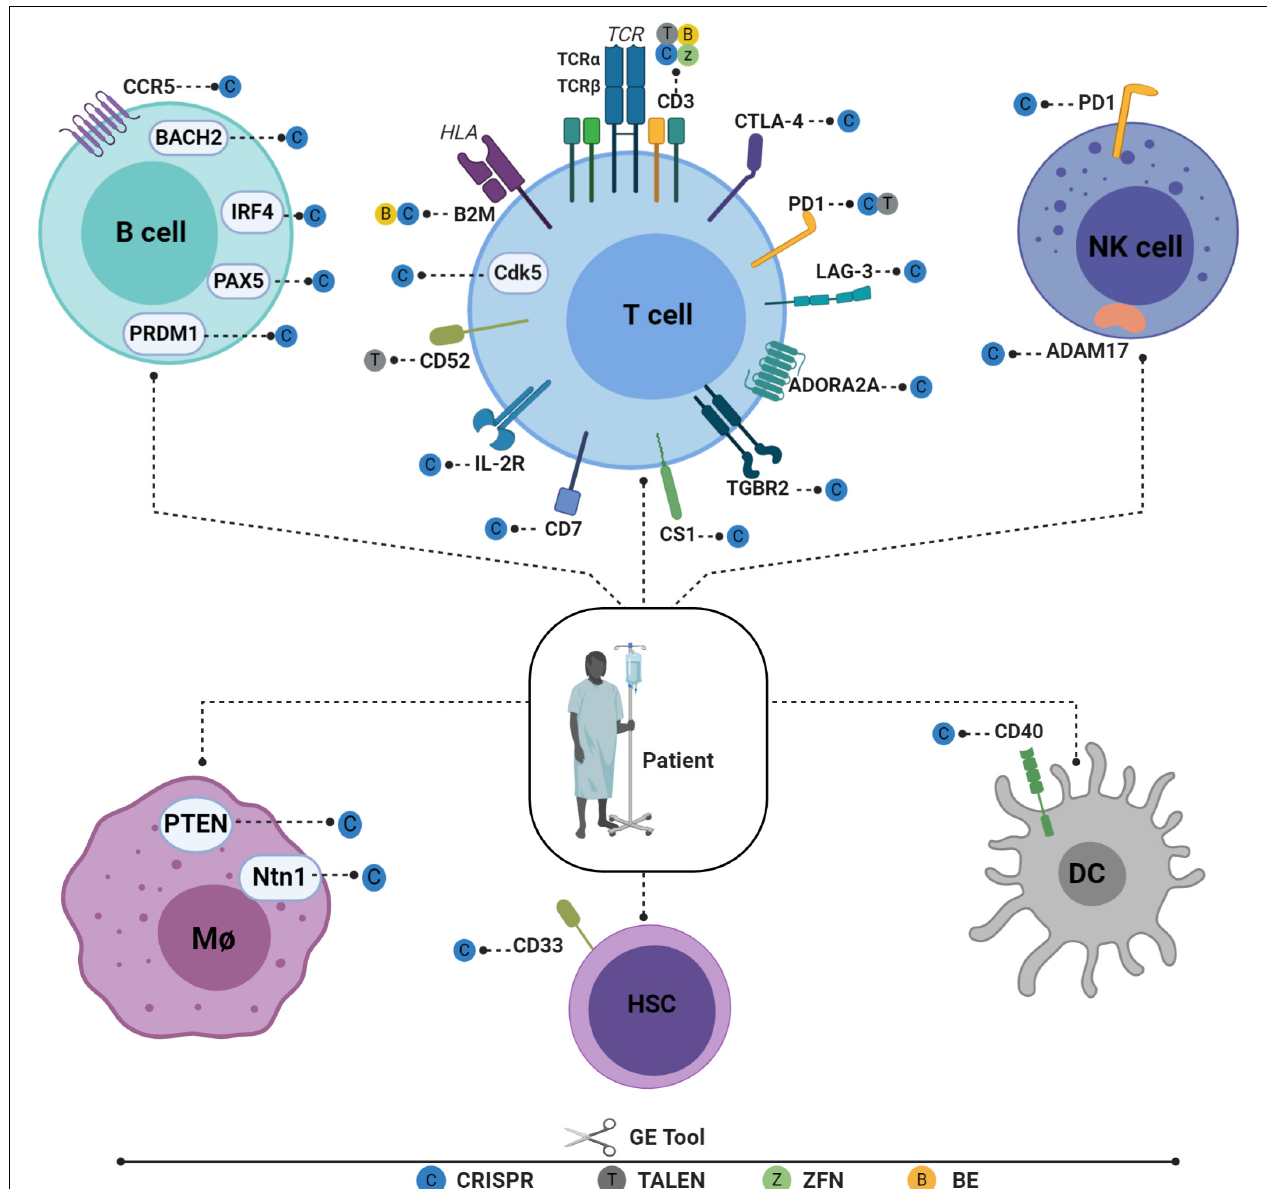
FIGURE 2 | Recent advances in engineering different immune cell types for immunotherapy applications. Engineered T cells in the B2M gene have lowered HLA class I antigen expression on the cell surface and have reduced the possibility of graft rejection. TCR/CD3 cells have been knocked out to reduce GVHD and to enable physiological CAR expression, thus enhancing CAR T potency. Tumor-suppressive microenvironments have been overcome by downregulating CTLA-4, PD1, and LAG-3. T cells have also been engineered to ignore suppressive signals by expressing dominant negative TGF beta receptors (TGBR2). On the other hand,